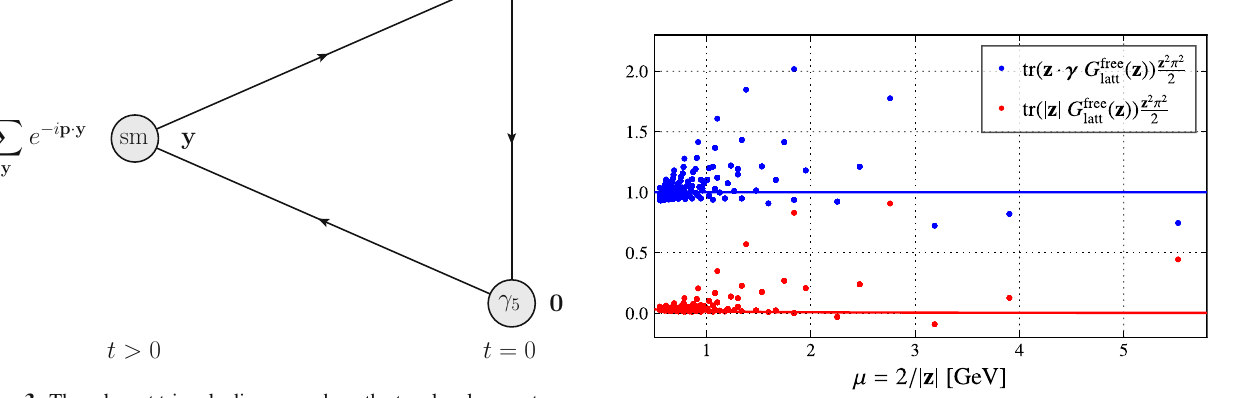
Fig. 4 The (free field) discretization effects of the Wilson propagator